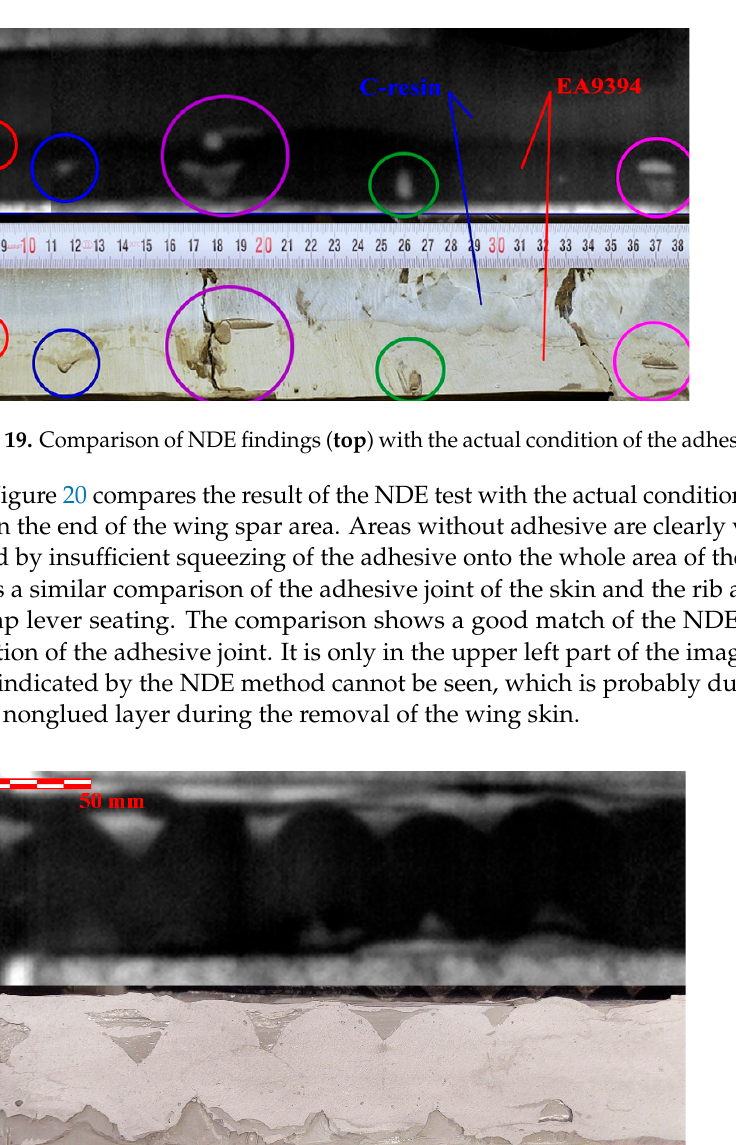
15 of 20 Figure 18. Results of the PT NDE method: adhesive joint of the front wing spar and the upper wing side in the fuel tank area. Due to the fact that no etalons with artificial defects were available for testing, an additional comparison of the NDE findings, with the actual condition of the adhesive joint at the failure area, was performed following the static strength test of the wing demon- strator. In the main wing spar area, the CFRP wing skin was removed to the depth of the adhesive joint. Figure 19 shows a comparison of the NDE findings with the actual condition of the adhesive joint. The upper part of the image contains an evaluated picture of the adhesive joint before the structural strength test. The lower part shows the condition of the adhesive joint after the strength test and the resulting wing damage. The individual colored circles mark the corresponding defects of the joint. The NDE measurement shows a good match with the actual condition of the joint. The smallest detected defect (marked